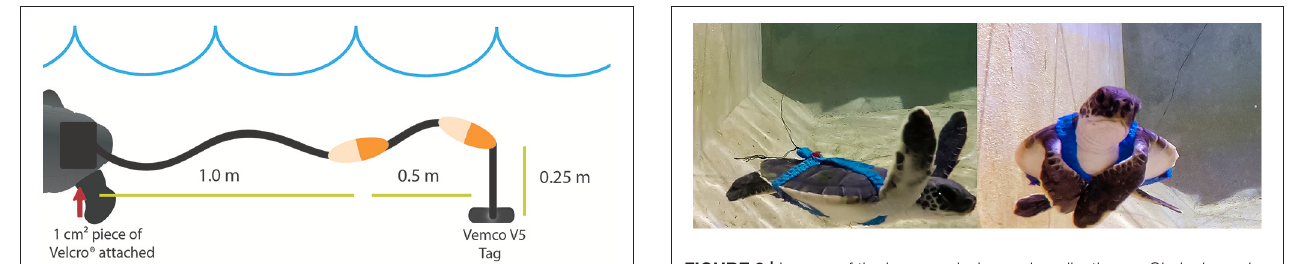
was affixed to the turtles’ carapace by one of two methods.